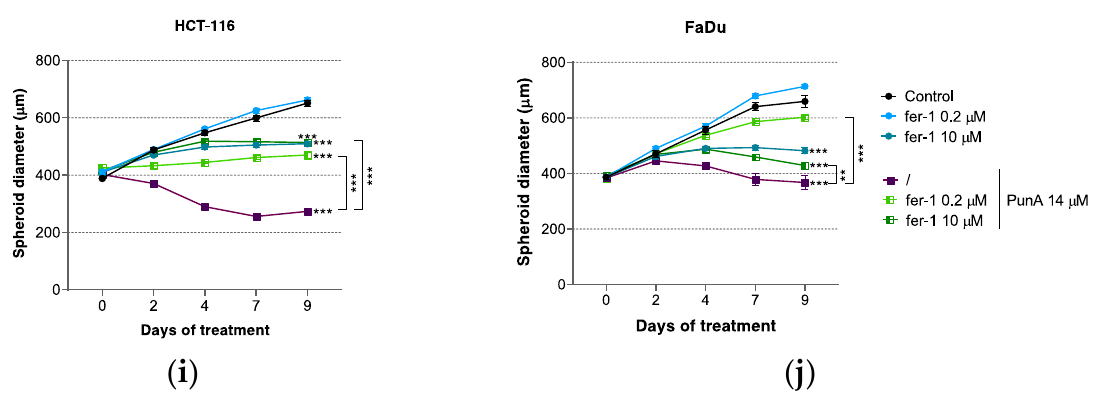
Figure 3. The effect of punicic acid (PunA) is inhibited by the addition of ferroptosis inhibitors. ( a – e ) Viability of HCT-116 carcinoma cells in the presence of PunA 14 µM and an increasing dose of ( a ) α -tocopherol ( α -T), ( b ) ferrostatin-1 (fer-1) or ( c ) deferoxamine mesylate (DFOM). ( d , f ) Viability of FaDu carcinoma cells in the presence of PunA 14 µM and an increasing dose of ( d ) α -T, ( e ) fer-1 or ( f ) DFOM. ( g , h ) Diameter growth of ( g ) HCT-116 and ( h ) FaDu 3D spheroids treated with PunA 14 µM and/or 0.2 or 10 µM of α -T. ( i , j ) Diameter growth of ( i ) HCT-116 and ( j ) FaDu 3D spheroids treated with PunA 14 µM and/or 0.2 or 10 µM of fer-1. Control: cells supplemented with DMEM cell culture medium without added fatty acid or spheroids supplemented with DMEM cell culture me- dium containing 0.3% v/v of DMSO. Vehicle: ethanol absolute for α -T (0.4% v/v ) or DMSO for fer-1 and DFOM (0.4% v/v ). Results are expressed as mean ± standard error of the mean of three inde- pendent repetitions. Significance is established in relation to the PunA + vehicle condition ( a – f ), to the control ( g – j ) or to PunA 14 µM alone ( g – j ). ** p ≤ 0.00143; *** p ≤ 0.0001.